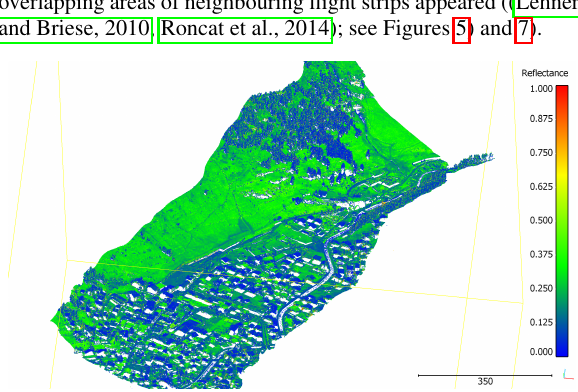
Figure 4: ALS point cloud of Figure 2, colour-coded by the cal- culated diffuse reflectance value.